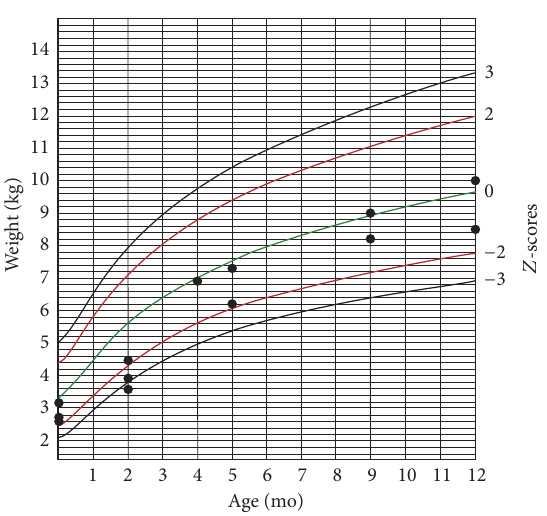
Figure 1: Weight-for-age chart for boys during one-year